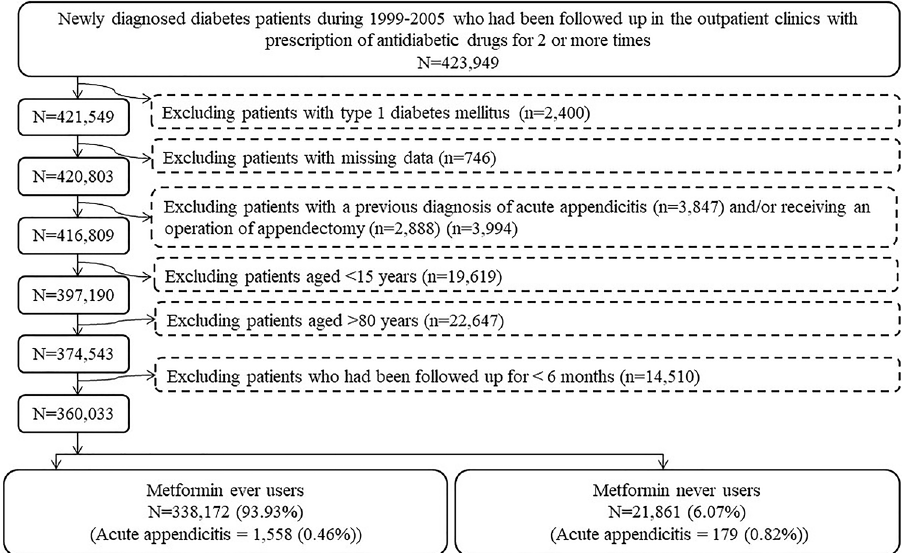
Figure 1. The procedures followed in enrolling ever users and never users of metformin from Taiwan’s National Health Insurance